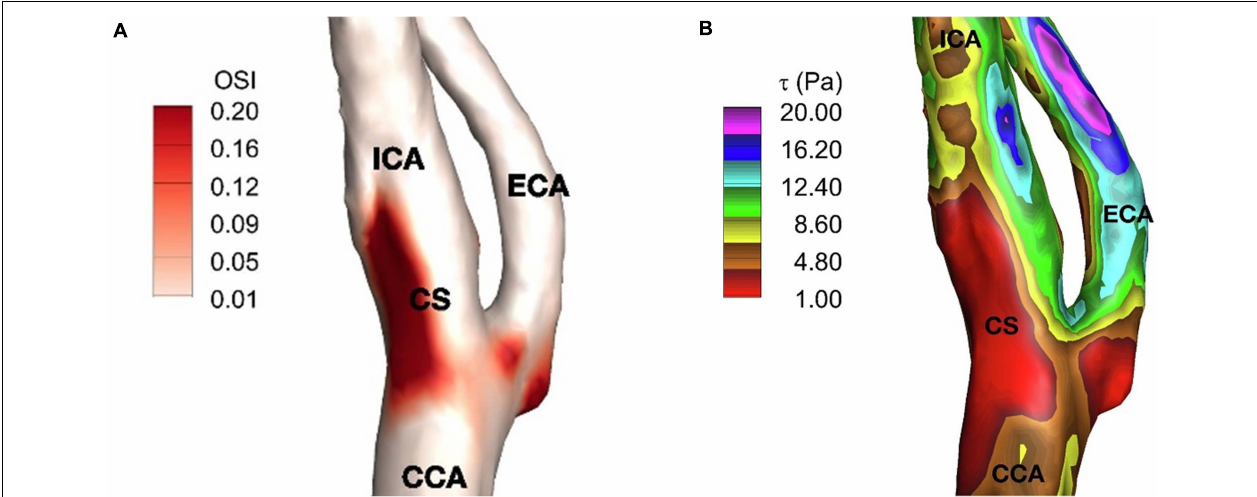
FIGURE 4 | (A) Time-averaged wall shear stress , (B) oscillatory shear index on carotid artery. ICA, internal carotid artery; ECA, external carotid artery; CCA, common carotid artery; and CS, carotid sinus (Iskander et al.,